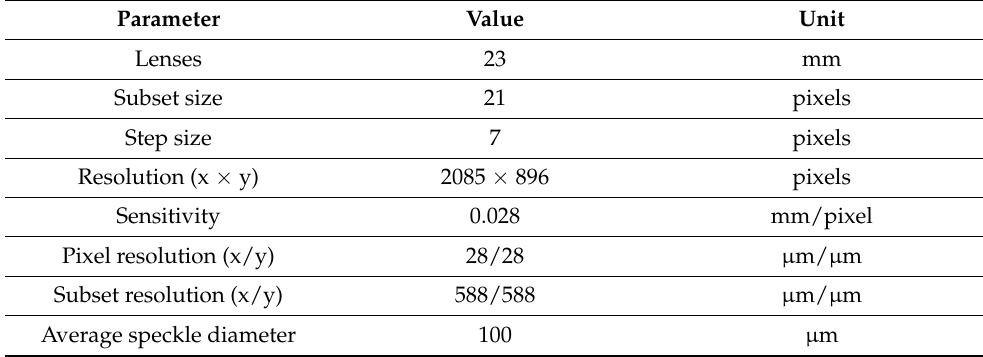
Table 3. Digital Image Correlation (DIC) system configuration.